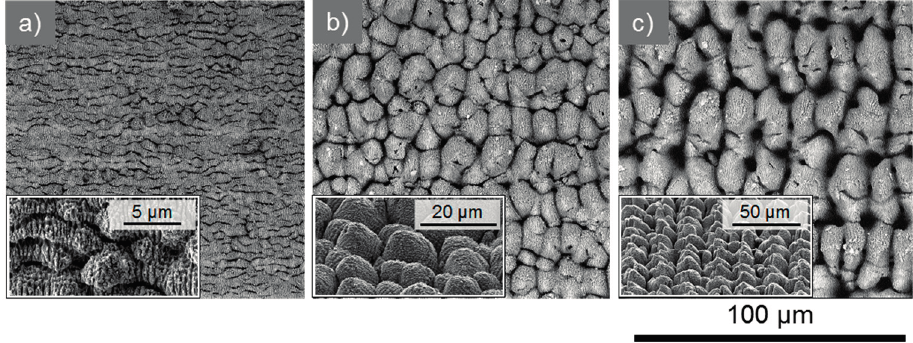
Figure 6. Laser-induced microstructures on titanium. ( a ) Undulating grooves covered with LIPSS. Inset: high magnification image. ( b ) and ( c ) Columnar structures at single scan and overscan, respectively. Inset: high magnification image of samples tilted at an angle of 40°